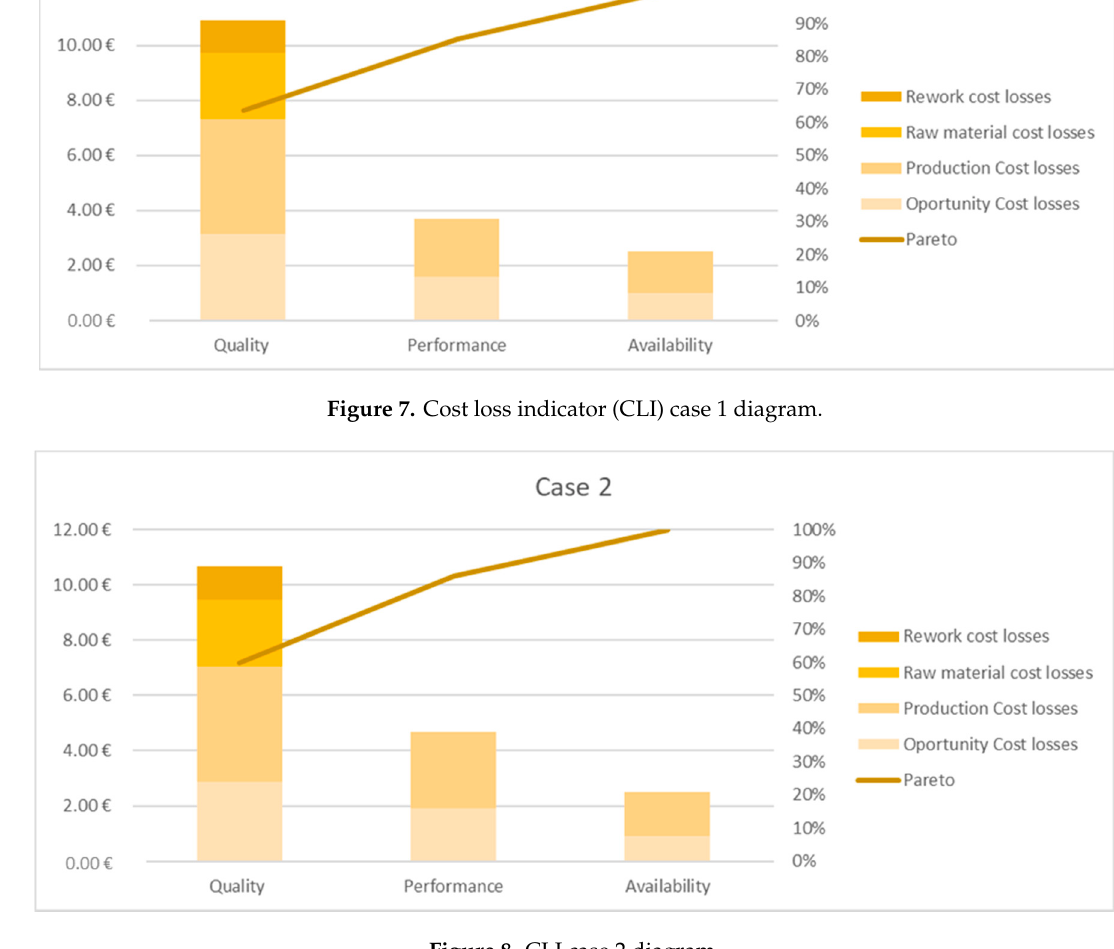
Figure 8. CLI case 2 diagram.